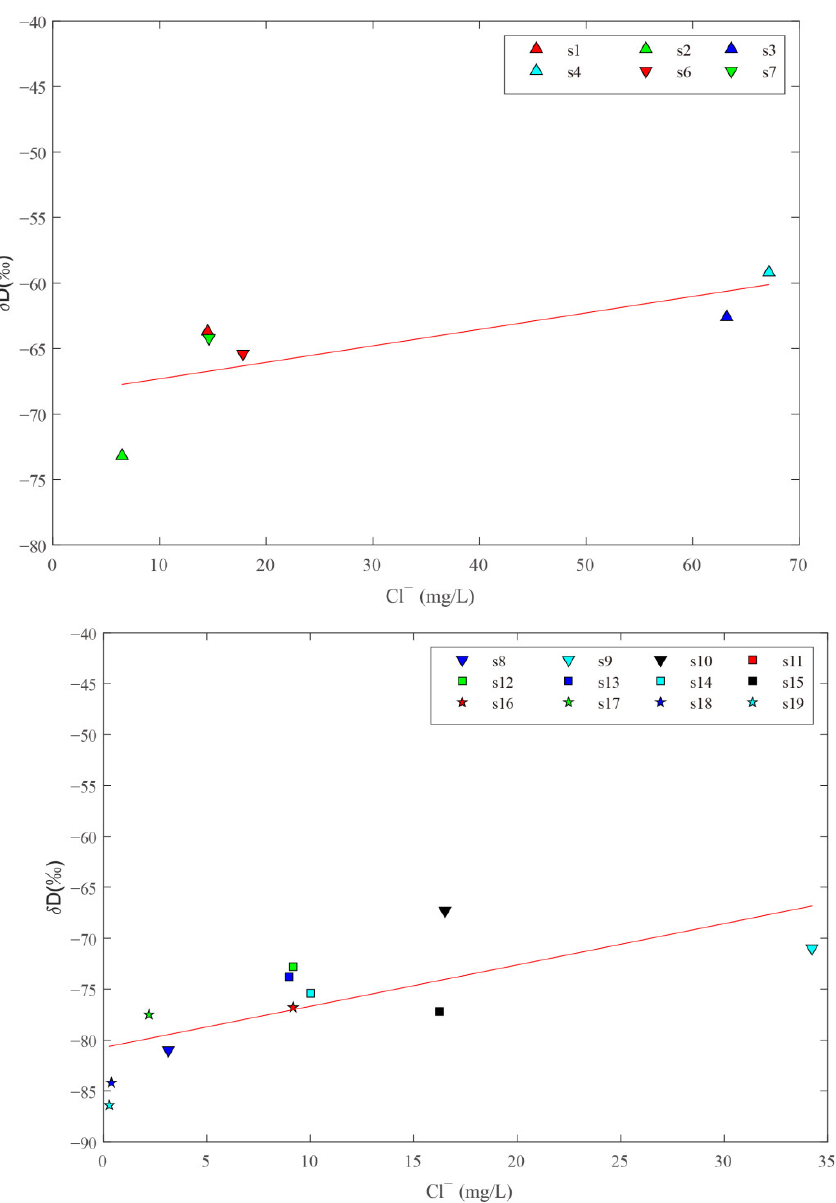
Figure 10. Relations of δD with Cl-, for various waters, at the intersection of the RRF and the